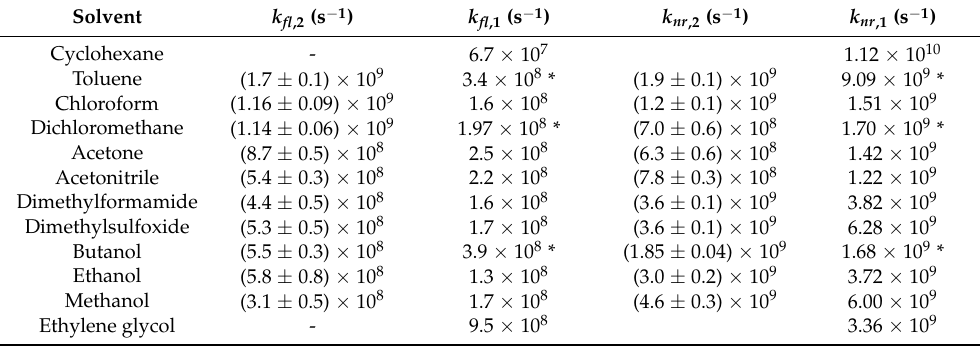
Table 5. Radiative and non-radiative decay rates, k fluo , 2 and k nr , 2 , calculated for 2 in the different solvents of Table 1, are compared to those of 1 , k fluo , 1 and k nr , 1 , reproduced from